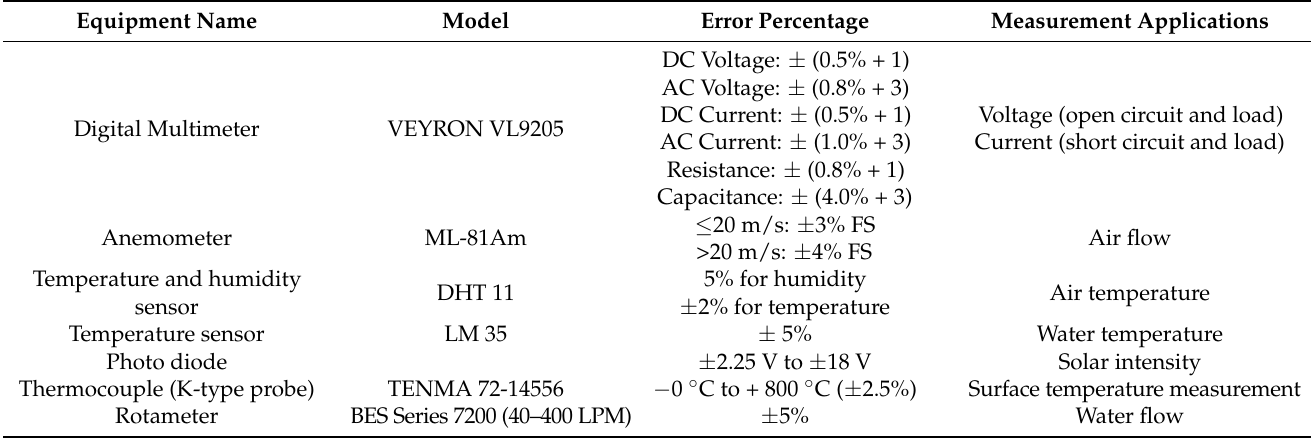
Table 2. Specifications of the measurement